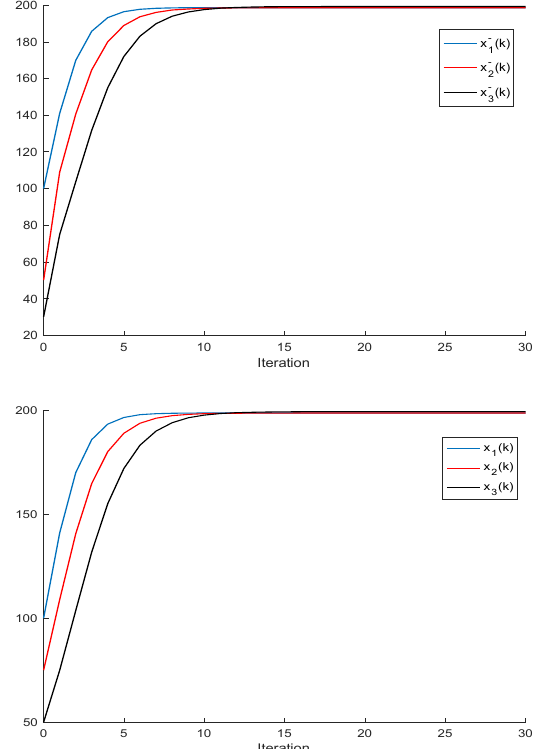
Figure 8. Evolution of x 1 ( k ), x 2 ( k ) and x 3 ( k ) for constant parameters in Example 5 when harvesting quota is included and coupling matrix C has small non-diagonal components.